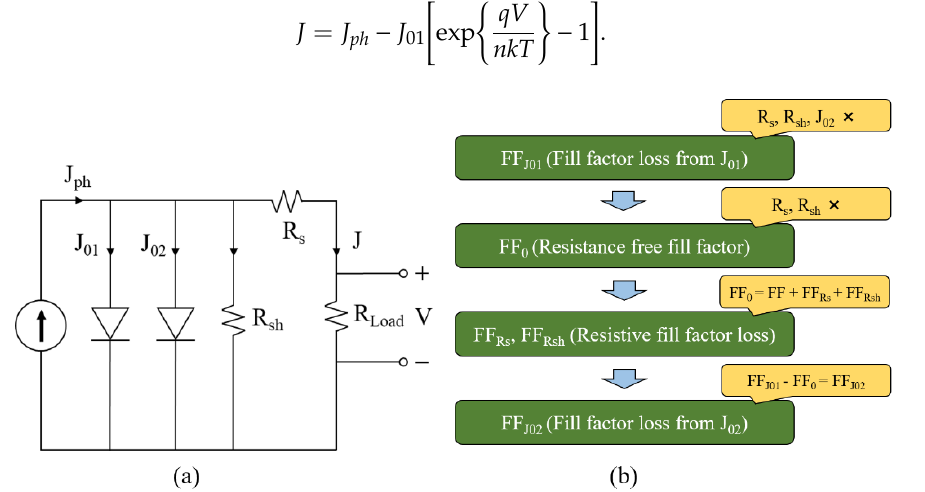
Figure 2. ( a ) Equivalent circuit of solar cells with double-diode model, and ( b ) process of fill factor loss analysis.